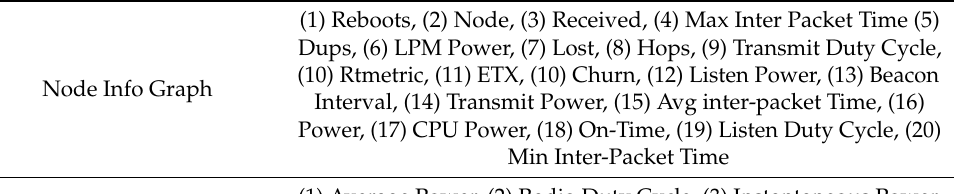
Node Info Graph